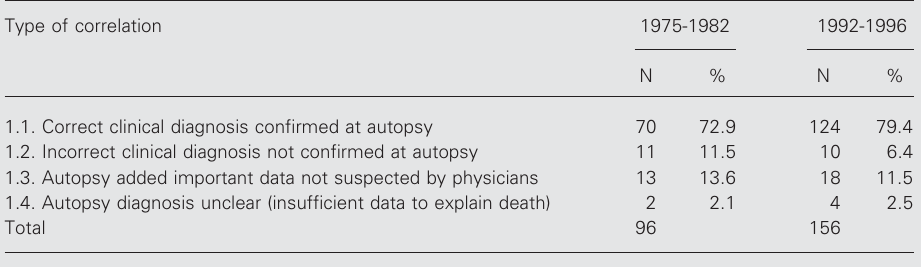
Table 1. Basic causes of death: correlation between clinical diagnoses and autopsy findings during two different periods (Faculdade de Medicina de Botucatu, São Paulo, Brazil). Type of correlation